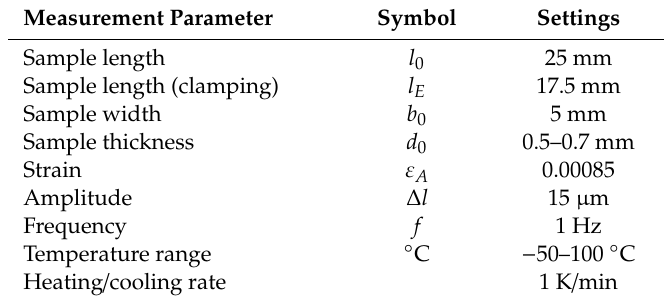
Table 3. Measurement parameters for Dynamic Mechanical Analysis (DMA).